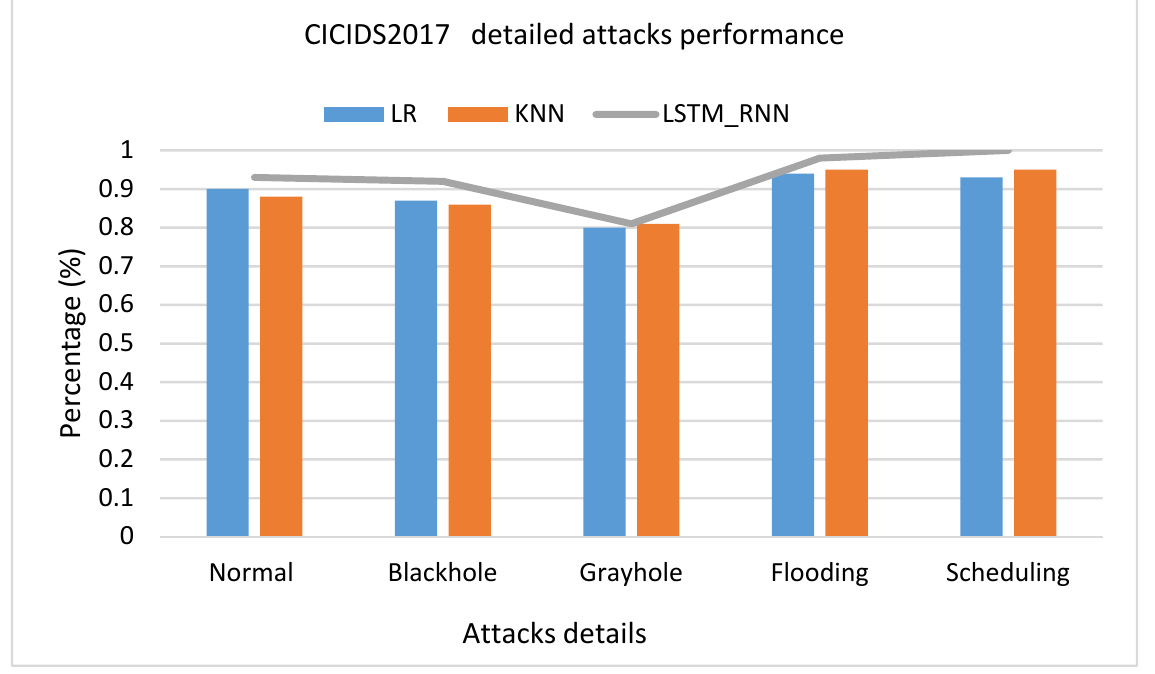
Figure 26. CICIDS2017 detailed attacks classification accuracy comparison.